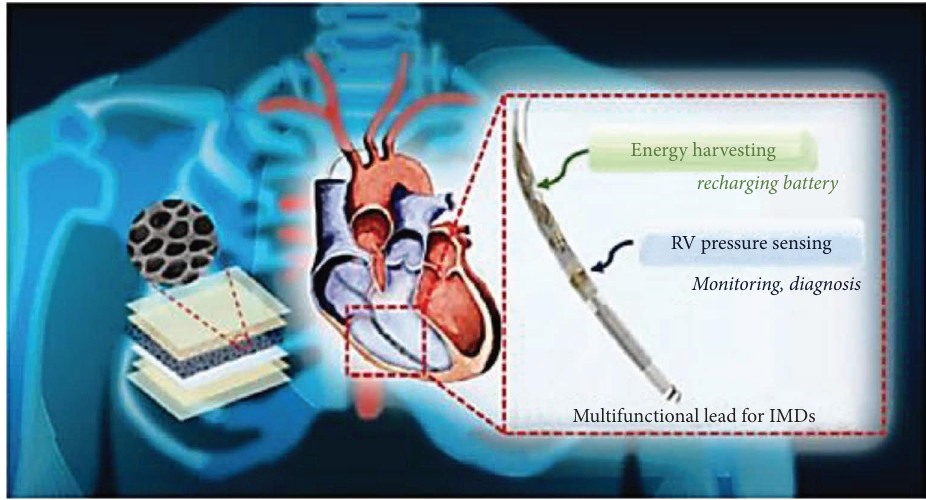
Figure 4: Multipurpose pacemaker lead that integrates energy harvesting and sensing techniques. Table 3: Representative sensing system for endocardial pressure and heart rate